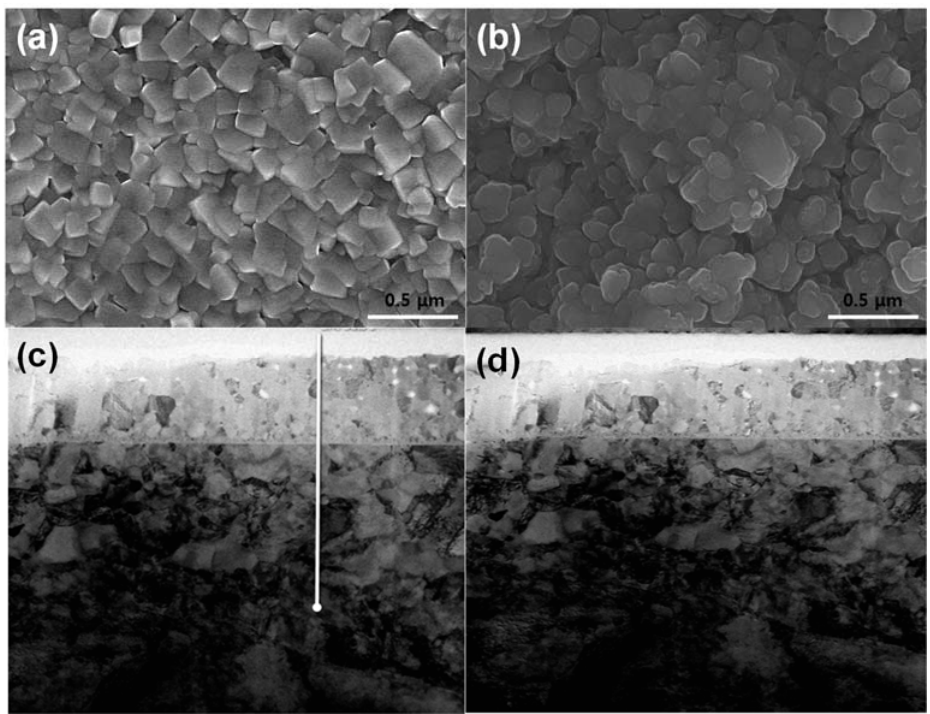
Figure 10. Surface morphologies of the NFO-800 electrode ( a ) before and ( b ) after cycles; ( c ) cross- section image; ( d ) cross-section image.